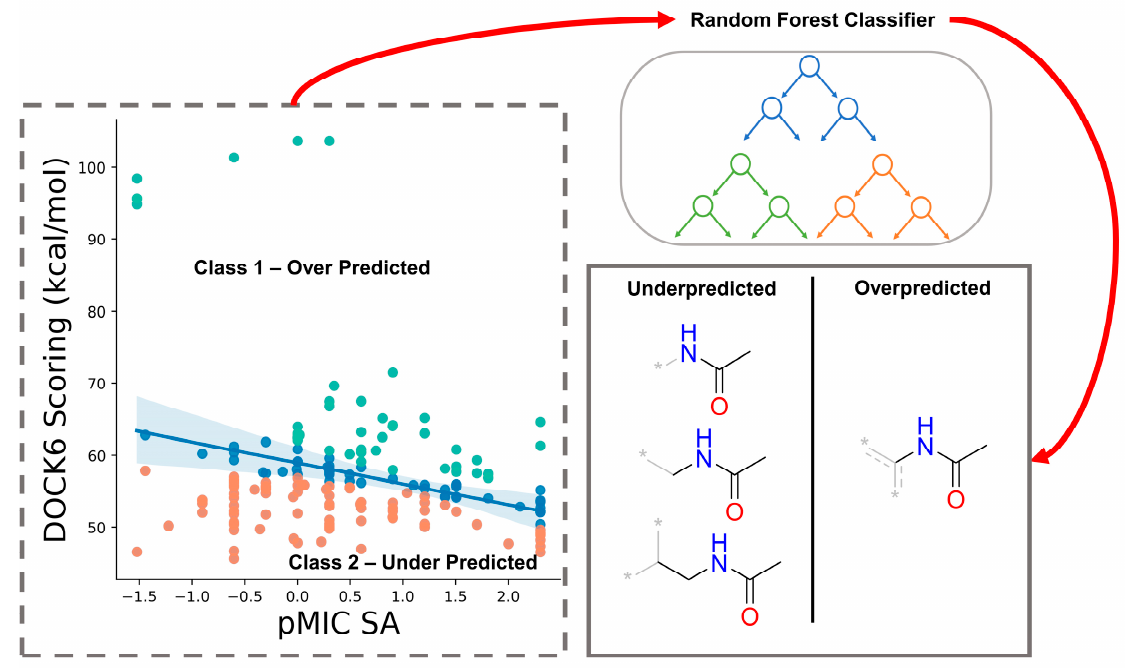
Figure 7. A brief overview of the random forest classifier. The classifier is trained on each derivative’s Morgan fingerprint bit vectors to identify sections of the structure that may contribute to over- or under-predictions by the scoring function. Over-predicted derivatives are indicated by green and under-predicted by orange. The top-performing derivatives are outliers in the − 90 kcal/mol to − 100 kcal/mol range.